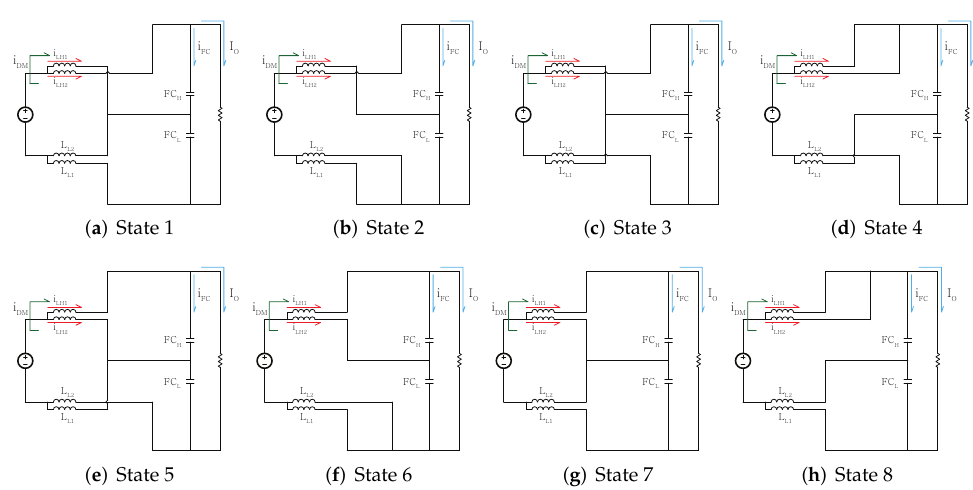
Figure 9. Circuit diagram according to the N-type interleaving switching operation. Table 2. High-side capacitor current for eight operating states of the N-type interleaving method. State